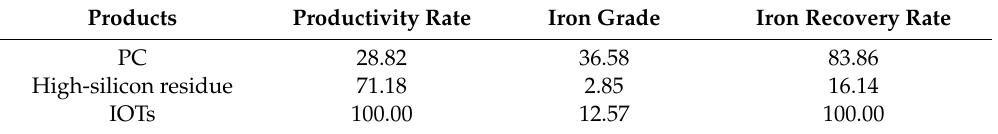
Table 5. Pre-concentration products / wt %. PC: Pre-concentrated concentrate.